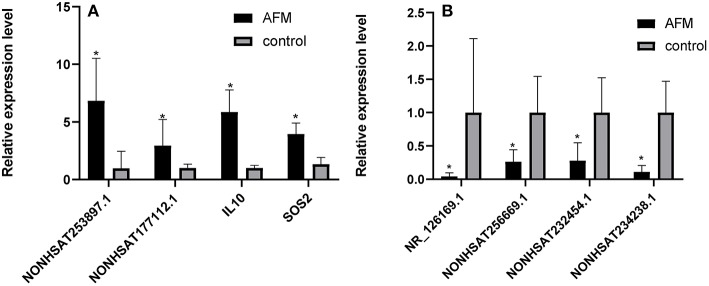
Comparison of the relative RNA expression levels between AFM patients and normal children. The expression of 2 upregulated mRNAs (A) and 3 downregulated and 1 upregulated lncRNA (B) were validated using the 2−ΔΔCt method. The data are displayed as the mean ± SD, and samples of the two groups were compared using the Mann-Whitney U test. *P < 0.05; AFM acute fulminant myocarditis; lncRNAs long non-coding RNAs.